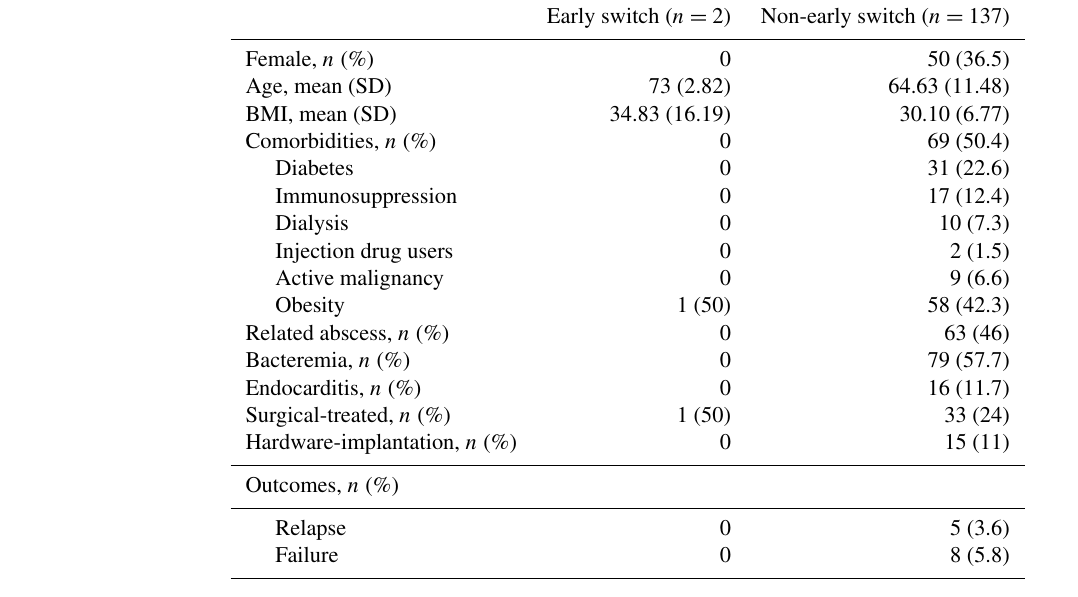
Table 2. Studies included in systematic review and